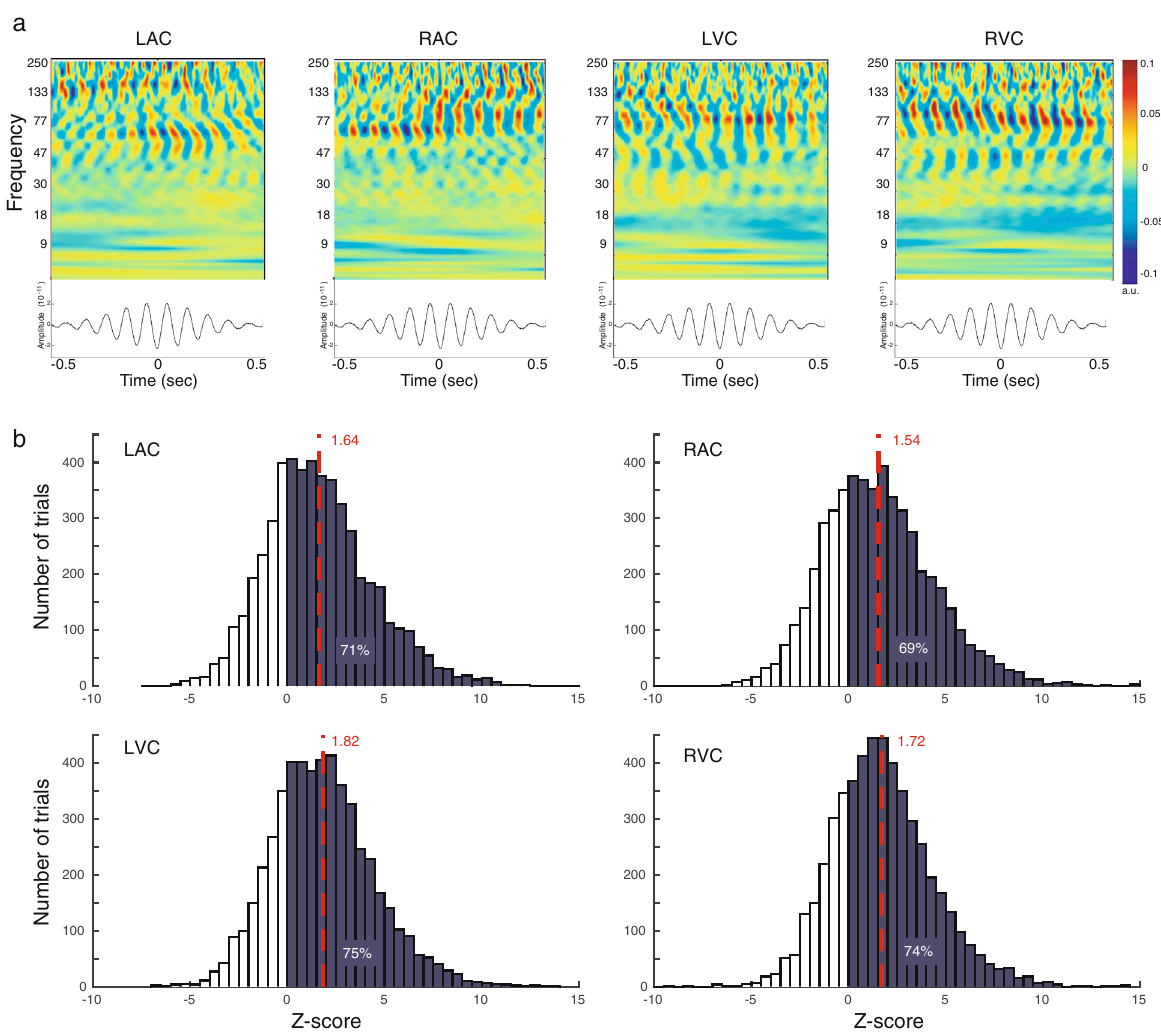
Fig. 4 Inter-trial, pre-stimulus PAC in auditory and visual cortex. a Empirical evidence of PAC manifestations in neurophysiological cortical traces. Time- frequency decompositions (top) of neurophysiological traces and their event-related average (bottom) time-locked to the troughs of slow-frequency fP (10 Hz) cycles, for each ROI in a representative participant. LAC, RAC: Left/right auditory cortex; LVC/RVC: Right auditory cortex. b Statistical signi fi cance of measured PAC effects. Group average ( n = 16) histograms of z-transformed PAC measures of task data across trials, relative to surrogates. Dark- shaded areas emphasize positive task PAC z-scores (where PAC was stronger than in surrogates) with their prevalence across trials in each region indicated as percentages. The dashed red lines indicate the mean task PAC z-score in each region, averaged across trials